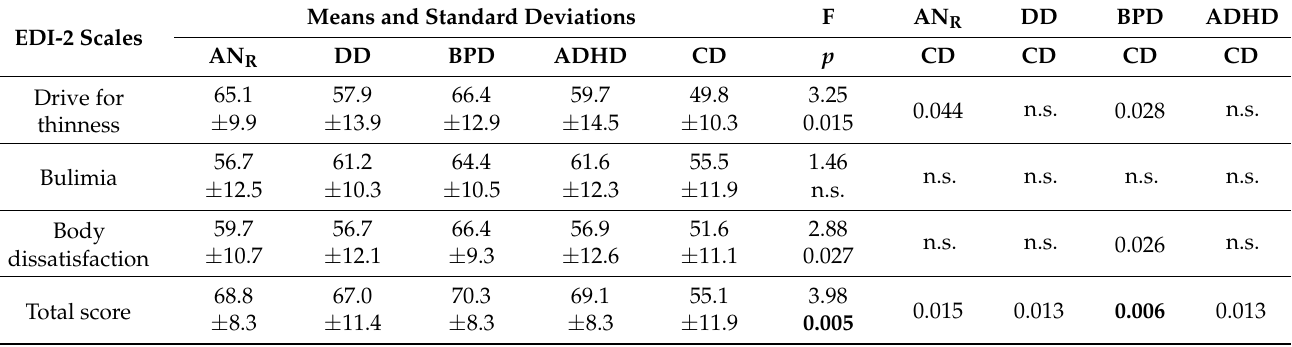
Table 2. Means and standard deviations of t -values for Eating Disorder Inventory 2 (EDI-2). Body- related subscales (drive for thinness, bulimia, and body dissatisfaction) and the total score were selected. One-way analysis of variance (ANOVA) was performed over EDI-2 subscales and the total score for different mental-disorder groups. Bonferroni post hoc tests were calculated between groups. Only one sample with Bonferroni post hoc test calculations features significant values between groups on α -level ≤ 0.01 (bold print); α -level ≤ 0.05 (light print); n.s. = not significant.